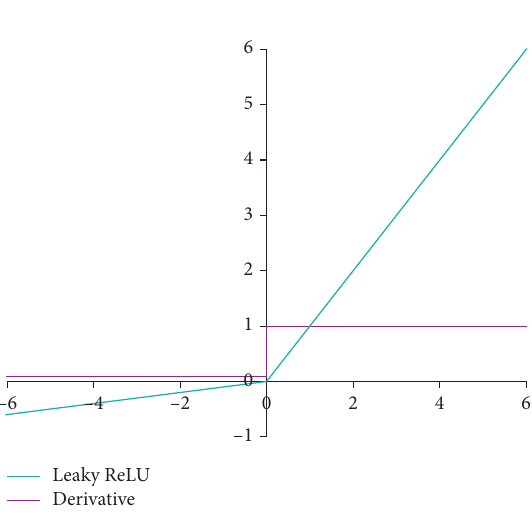
Figure 8: Leaky ReLU function and derivative.